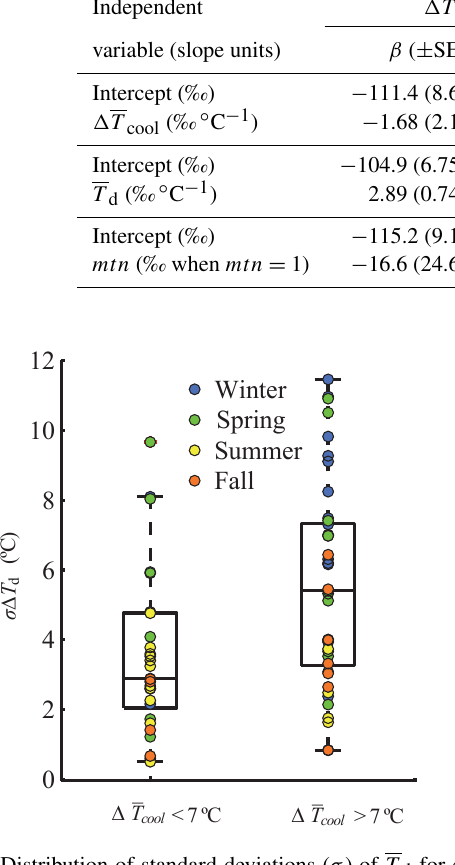
Figure 6. Distribution of standard deviations ( σ ) of T d for events with (cid:49)T cool <7 ◦ C (short trajectories) and (cid:49)T cool >7 ◦ C (long tra- jectories). Colors indicate seasons. In general, small (cid:49)T cool was associated with small σT d . The variation in standard deviation is related to season, where warmer months tend to have a smaller σT d and cooler months tend to have a larger σT d